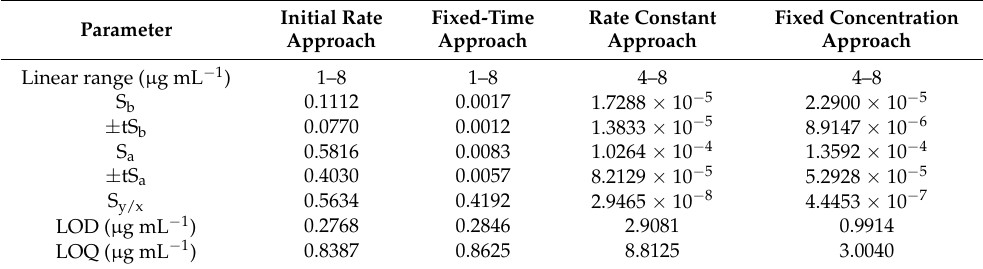
Table 10. Regression parameters for the approached kinetics